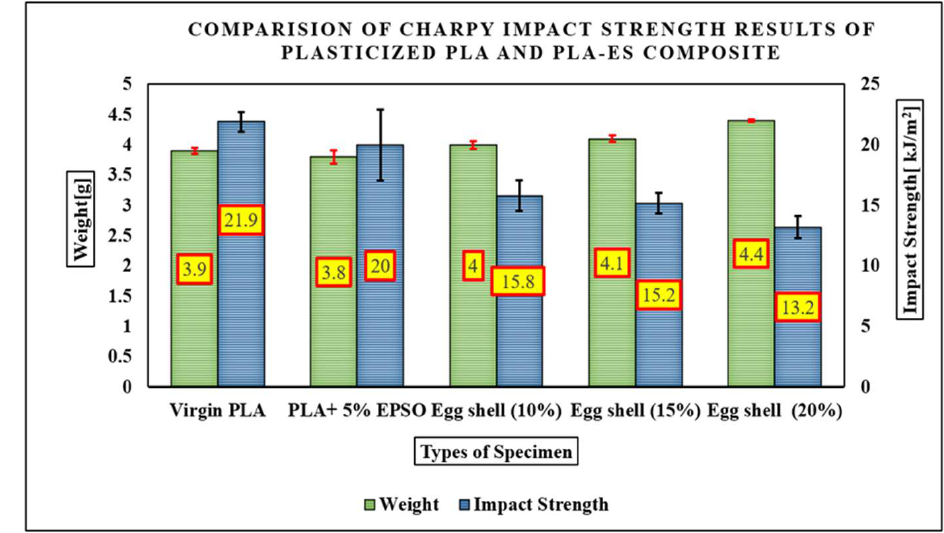
Figure 10. Charpy impact test result—Impact strength [kJ/m 2 ] comparison.